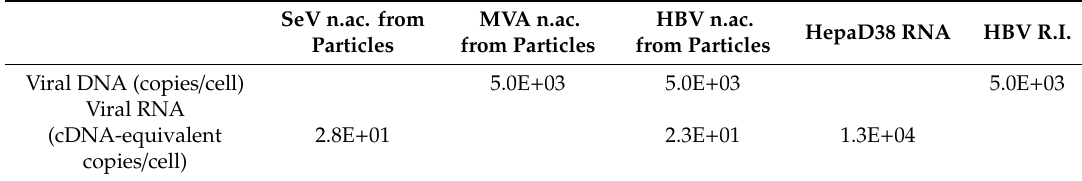
Table 3. Quantification of viral nucleic acids used for MDDC transfection experiments.